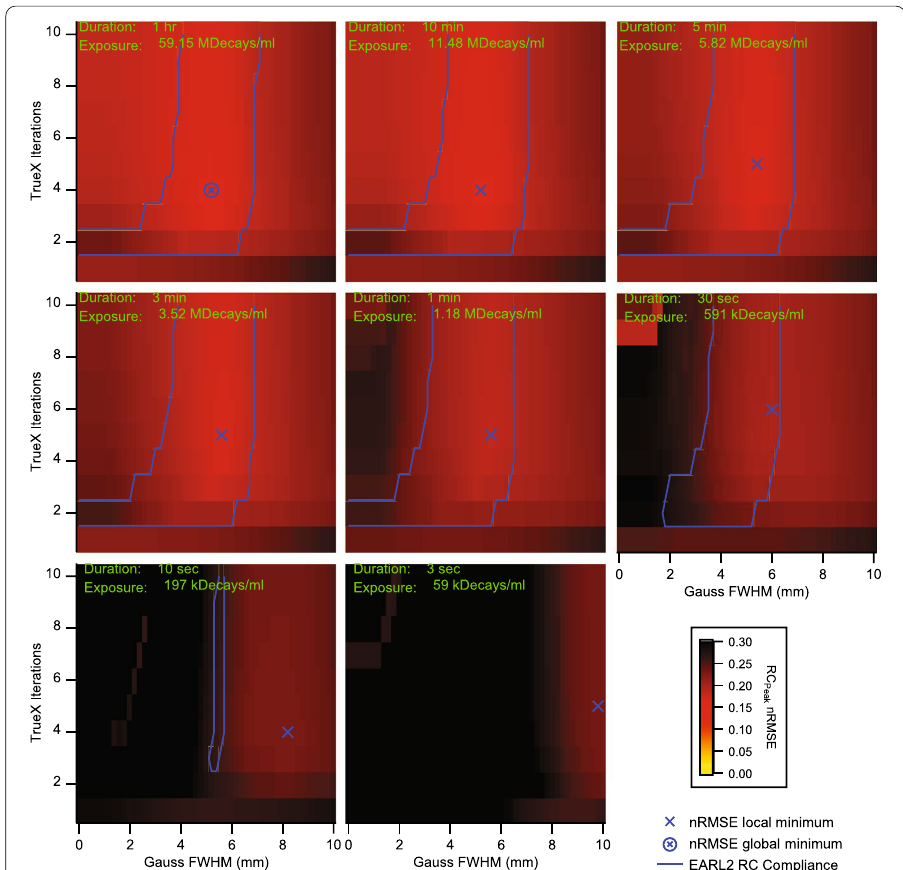
Fig. 5 Normalized RMSE for RC peak in reconstruction parameter space. Data within the blue contours passed the current EARL2 limits. The blue cross marks the local nRMSE minima; the cross in the circle marks the global nRMSE minimum. Panels are shown in order of decreasing exposure. The upper left corner of the 30 s panel was excluded from the nRMSE minimum consideration for reasons of